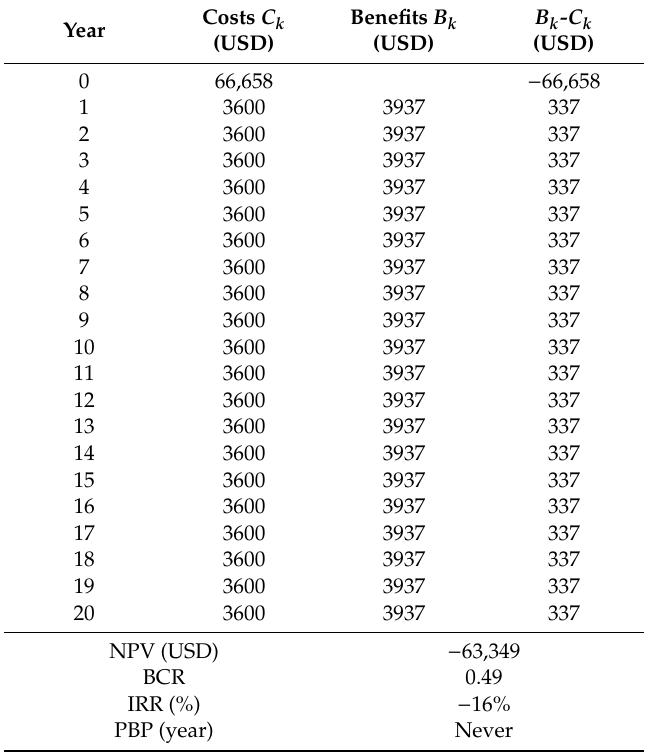
Table5. FinancialAnalysisappliedtothecasestudy: flowsandresults(economicindicators: